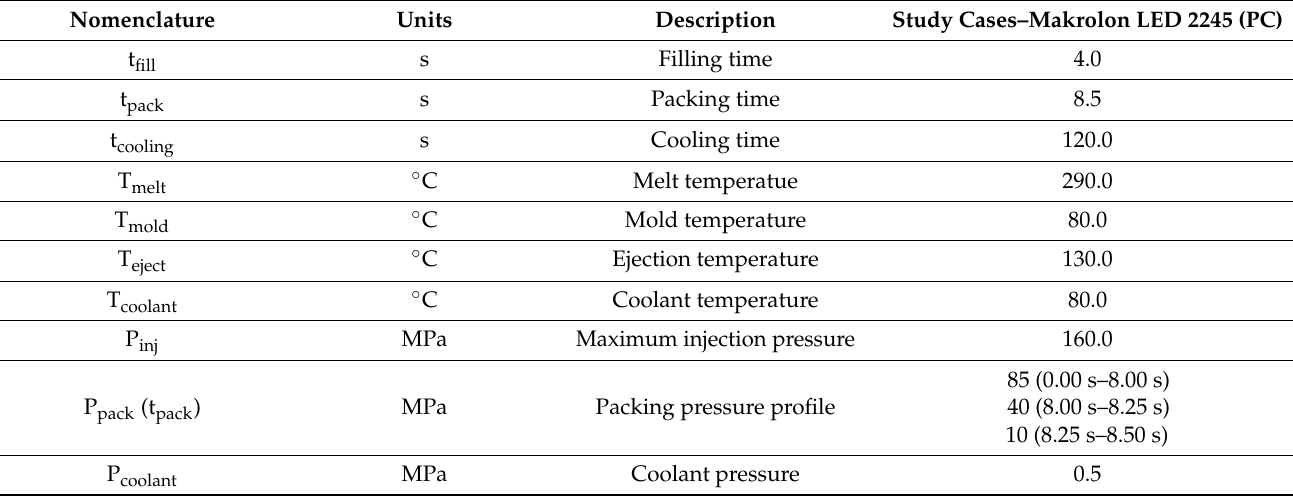
Table 8. Technological variables defined for the set-up of the filling and cooling stage for numerical